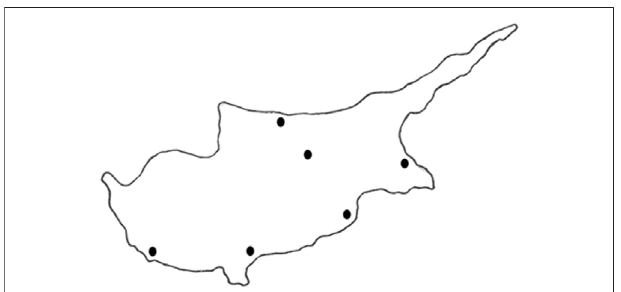
FIGURE 4 | Map used in the ‘ draw-a-map ’